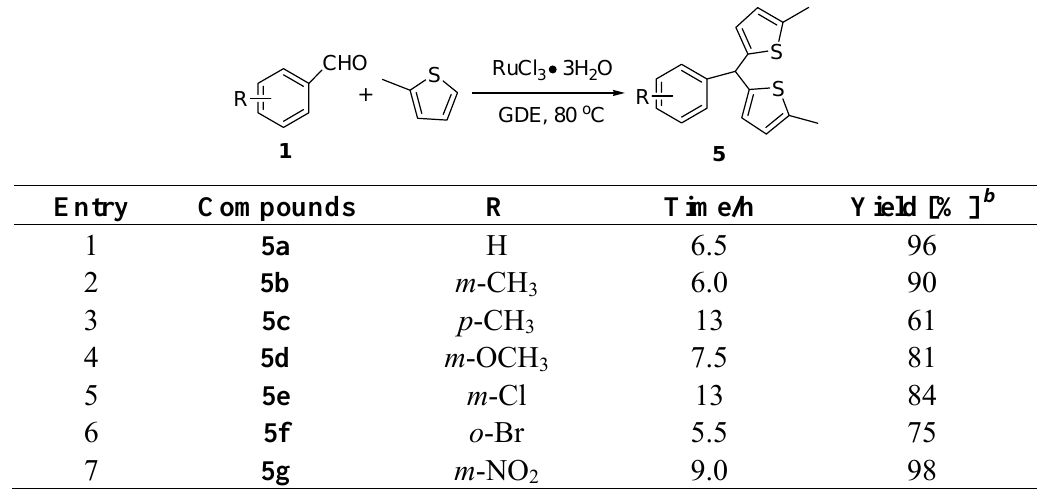
Table 3. RuCl ·3H O-catalyzed reaction of 2-methyl thiophene with aryl aldehydes a . 3 2